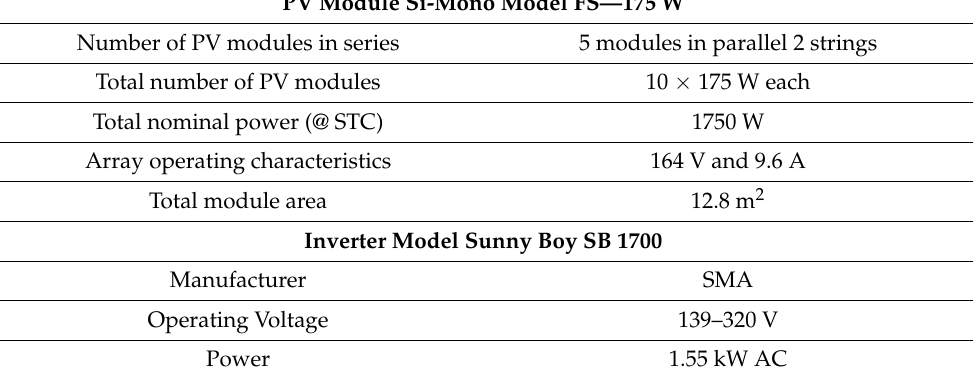
Table 1. PV system specification.